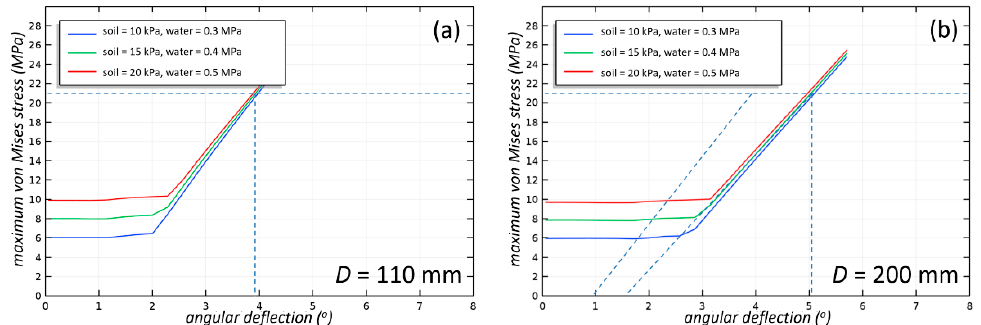
Figure 3. Typical results. ( a ) The von Mises stress as a function of angular deflection in a simulated system of a pipe and a coupling of a given design. Differently colored curves represent different static loading conditions during simulations. The dashed horizontal line corresponds to the failure criterion of 21 MPa and the vertical line corresponds to the matching maximum acceptable angular deflection. ( b ) Analogous results of a system with the same coupling design, but scaled to a larger diameter. The diagonal lines guide a comparison between